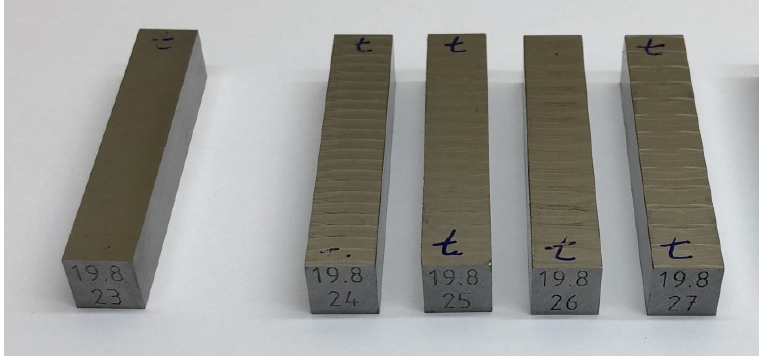
Figure 1. The investigated 22NiMoCr37 samples having different surface roughness conditions. Table 1. Manufacturing parameters and surface roughness parameters of the measured samples. Sample No.